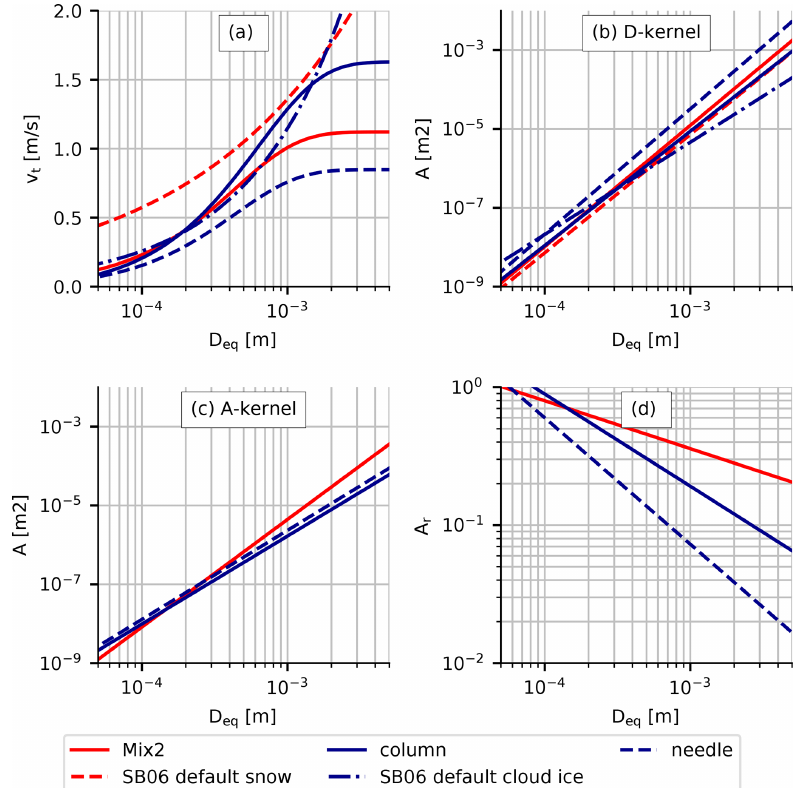
Figure 3. Particle properties from the default (SB06 default cloud ice, SB06 default snow) and modified version (column, needle, Mix2) of the scheme. (a) Terminal velocity v t , (b) projected area A of a circumscribing sphere (as assumed in D-kernel), (c) “real” projected area A considering the voids in the circumscribing sphere (as assumed in A-kernel), and (d) area ratio (Eq. 16). The default scheme does not assume an A – D relation explicitly, and therefore the real projected area and the area ratio are not given.